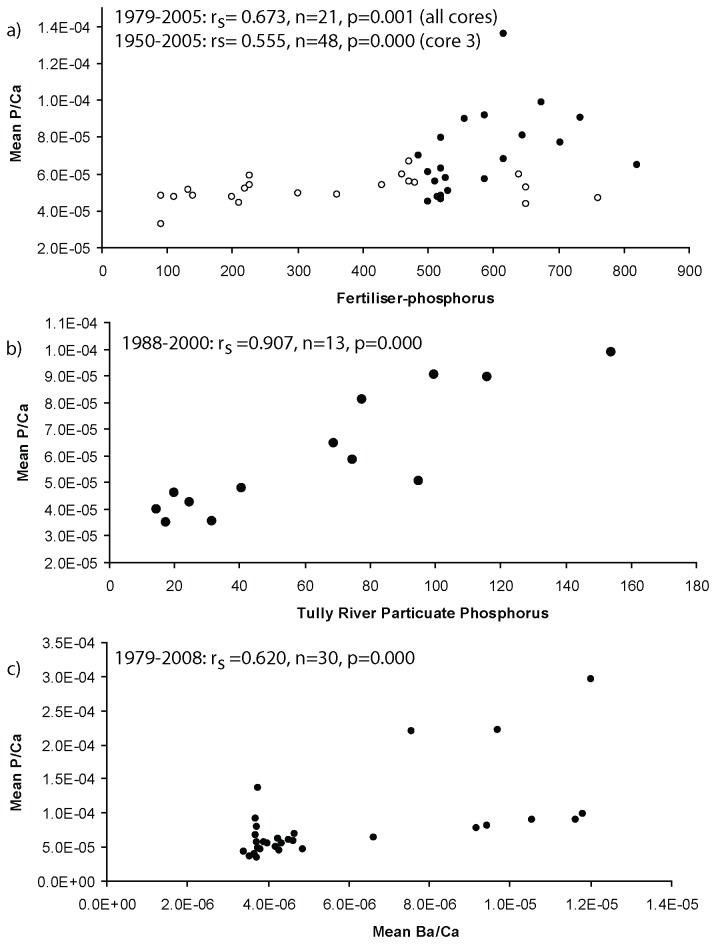
Scatter plots detailing mean P/Ca (mol mol-1) from Porites cores from Dunk Island and (a) fertiliser-phosphorus (tonnes), 1950-2005, open circles represent annual means from one long core 1950-1978 and filled circles represent annual means from all three cores from 1979-2005.Correlation detailed for the three core dataset time period (cores 1-3, 1979-2005) and separately for the longer time-frame (core 3, 1950-1978); (b) Tully River particulate phosphorus loads (tonnes) over 13 years, 1988-2000; and (c) Ba/Ca (mol mol-1) from 1979-2008. All data points represent annual means. Note all 3 graphs show highly significant correlations (p<0.01).